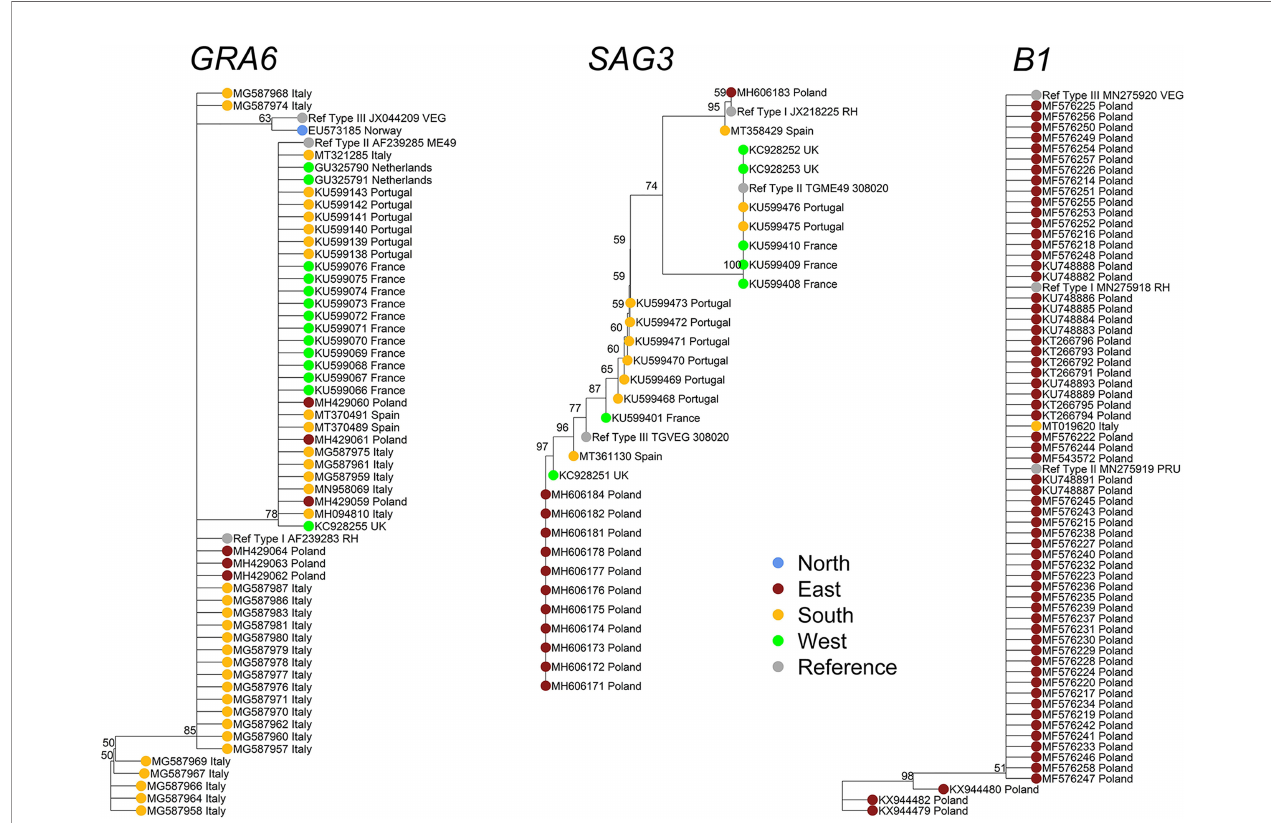
FIGURE 4 | Phylogenetic analyses of the Toxoplasma gondii population in Europe based on available GRA6 , SAG3 , and B1 -derived sequences. To analyze the genetic population of T. gondii in Europe based on the nucleotide sequences of different T. gondii -speci fi c markers, the respective entries were downloaded from the NCBI nucleotide database (https://www.ncbi.nlm.nih.gov/nucleotide?cmd=search) using the R package “ rentrez ” . In the fi rst step, using a search string ( e.g. , “ Toxoplasma[ORGN] AND GRA6[ALL] ” ), all available data on the respective markers were downloaded by the R function “ rentrez::entrez_search ” and “